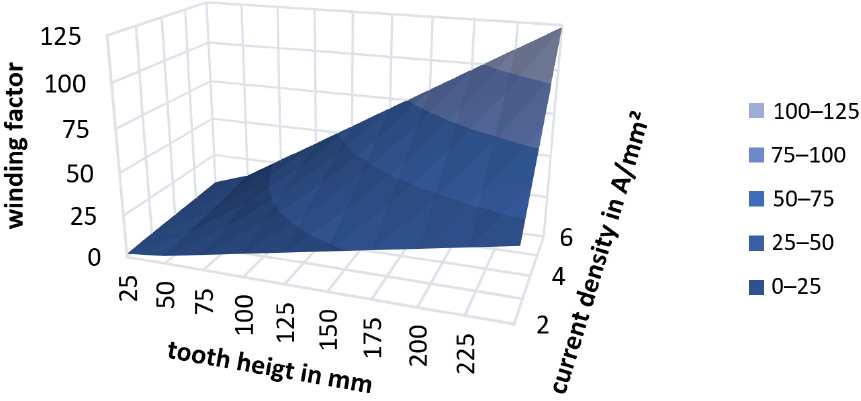
Figure 7. Winding factor depending on tooth height and current density.